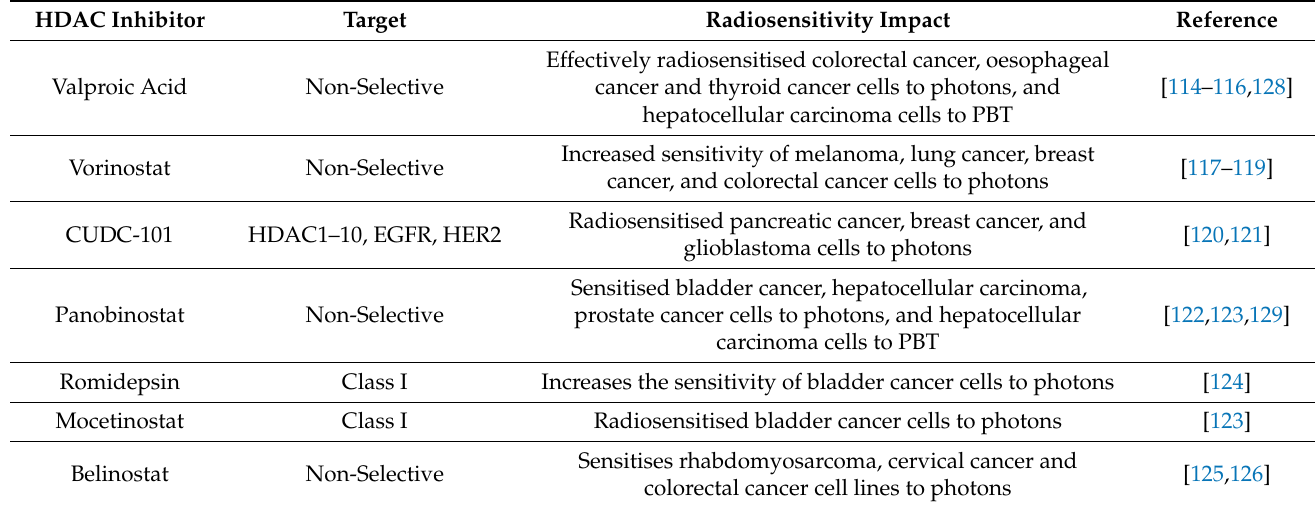
Table 2. Evidence of enhanced radiosensitisation of tumour cells with HDAC